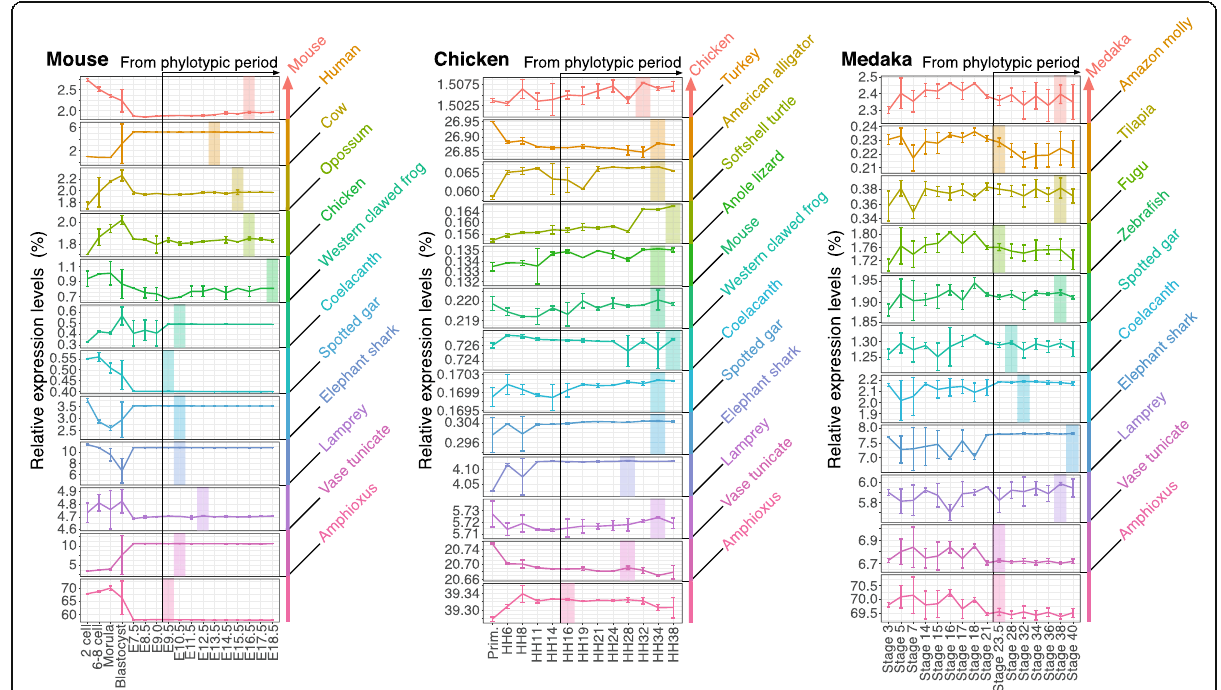
Fig. 4 No recapitulative pattern was observed in developmental gene expression levelsFor each developmental stage, summed expression levels of evolutionarily categorized protein-coding genes were shown as the percentage relative to the total expression levels of all evolutionary categories. The color of each category corresponds to the estimated evolutionary age of the protein-coding genes (shown at right). The evolutionary age of each protein-coding gene was estimated according to the most recent common ancestors of all the species sharing the homologs. Genes that were estimated to be secondarily lost in any of the compared species were excluded (see Methods for details). In each graph, developmental stages with the highest value after the potential phylotypic period are highlighted in the corresponding color. Error bars indicate the standard deviation of biological replicates for each developmental stage. Statistical information for the Kruskal – Wallis rank sum test is given in Additional file 1: Table